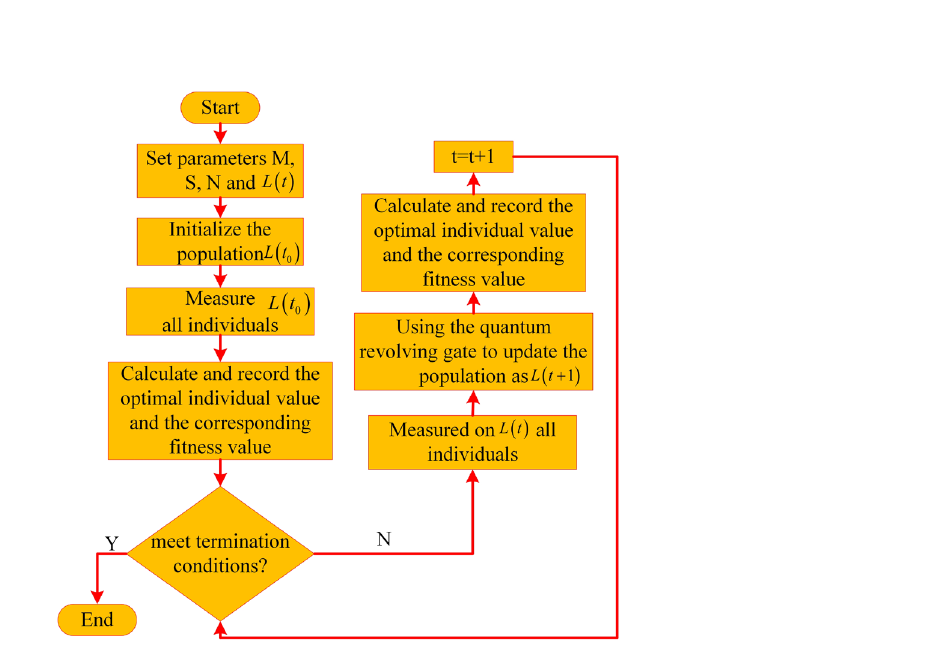
Figure 4. QGA optimized SVM parameter